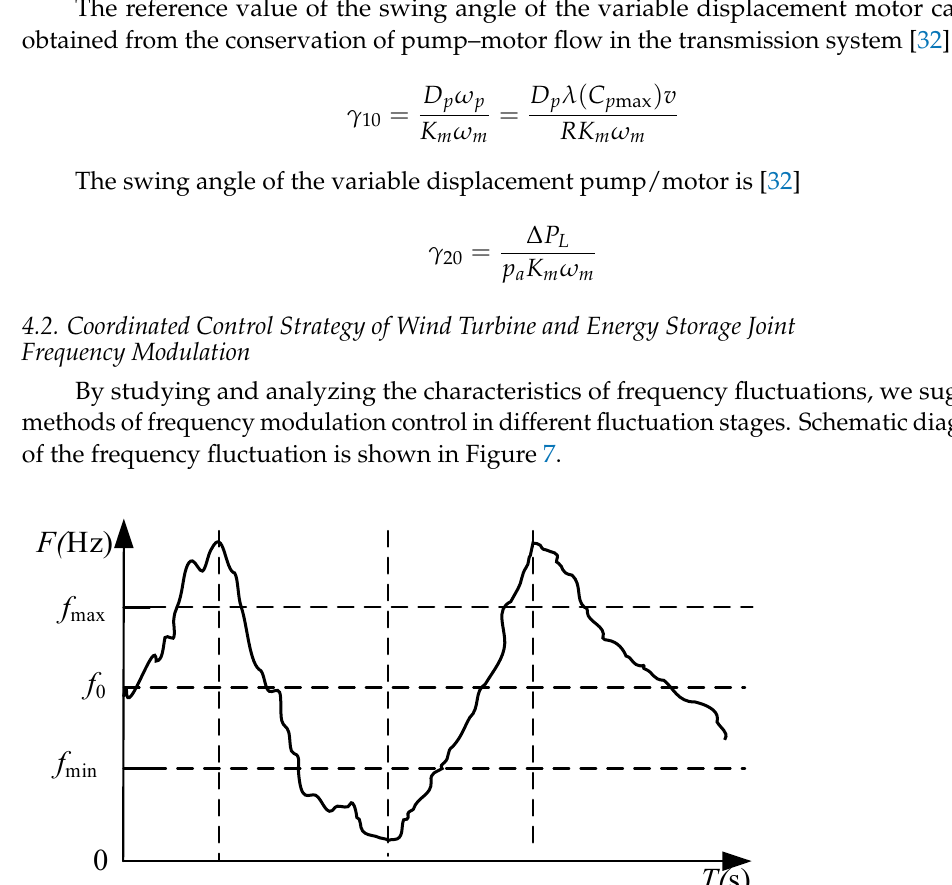
Figure 7. Schematic diagram of system frequency fluctuation.